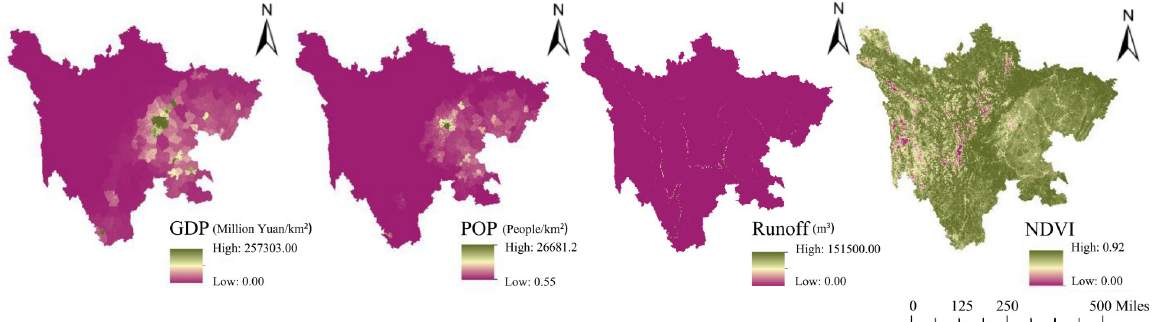
Fig 2. Spatial distribution of the four drivers in Sichuan